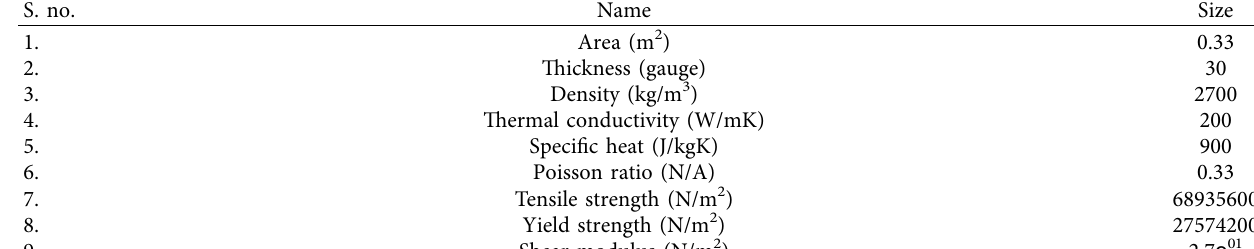
Table 3: Wooden tray size and material.